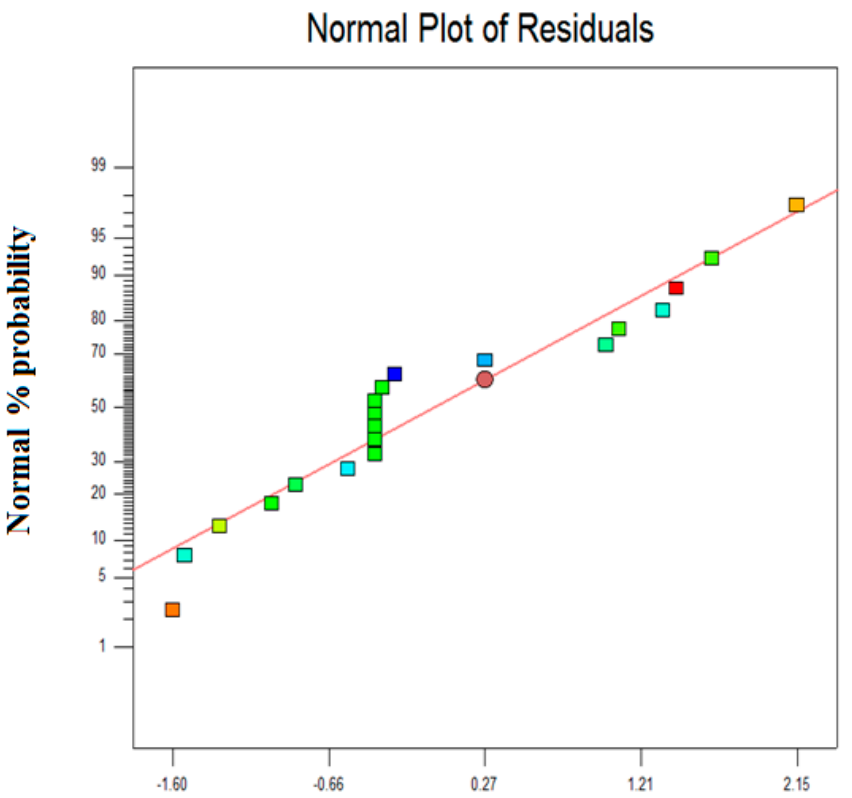
Figure 2. The normal probability vs studentized residual plot.